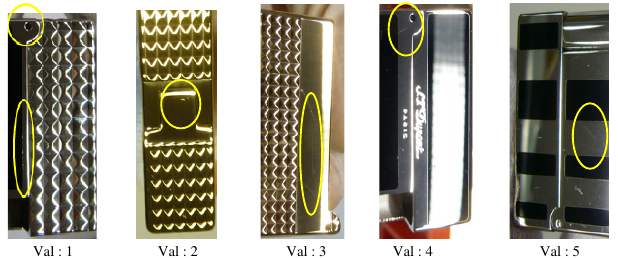
Fig. 17. Examples of value for the attribute “local